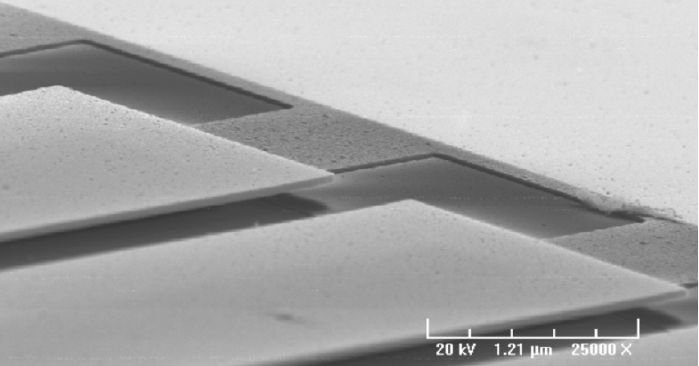
Figure 5. Detail of relative humidity sensor. Each top-electrode finger measures 1,150 µm × 40 µm and covers a 3 µm thick polyimide active layer deposited on top of the fingered bottom